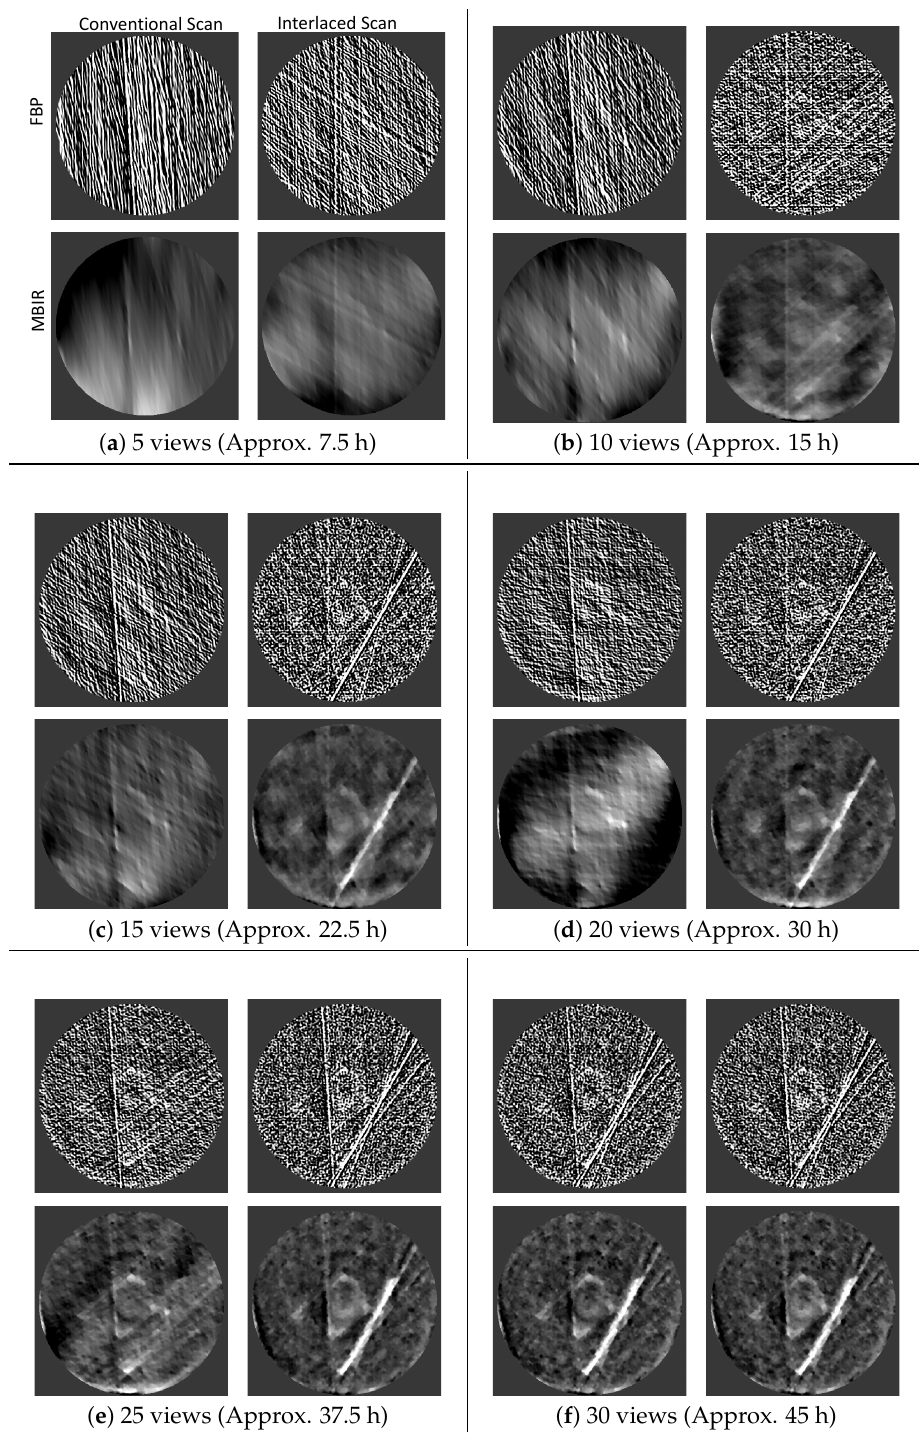
Figure 4. Cross section from the reconstruction of a single wavelength bin using filtered back projection (FBP) and model-based image reconstruction (MBIR) with different scanning protocols. In each inset, the top row is the FBP reconstruction, the bottom is the MBIR. The left column is the result from the conventional scan, while the right column is from the interlaced scanning strategy.